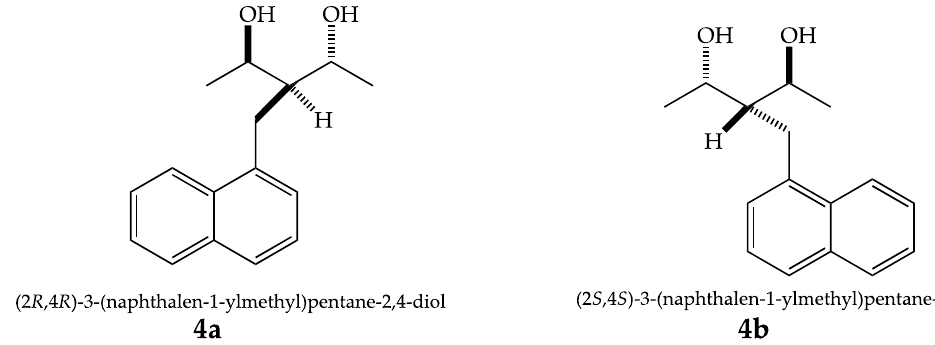
Figure 2. Crystal structure of compounds 4a ( left ) and 4b ( right ). Displacement ellipsoids are drawn at a 50% probability level. The intramolecular interactions are shown as dashed red lines. Table 1. Crystallographic data of compounds 4a and 4b . Complex